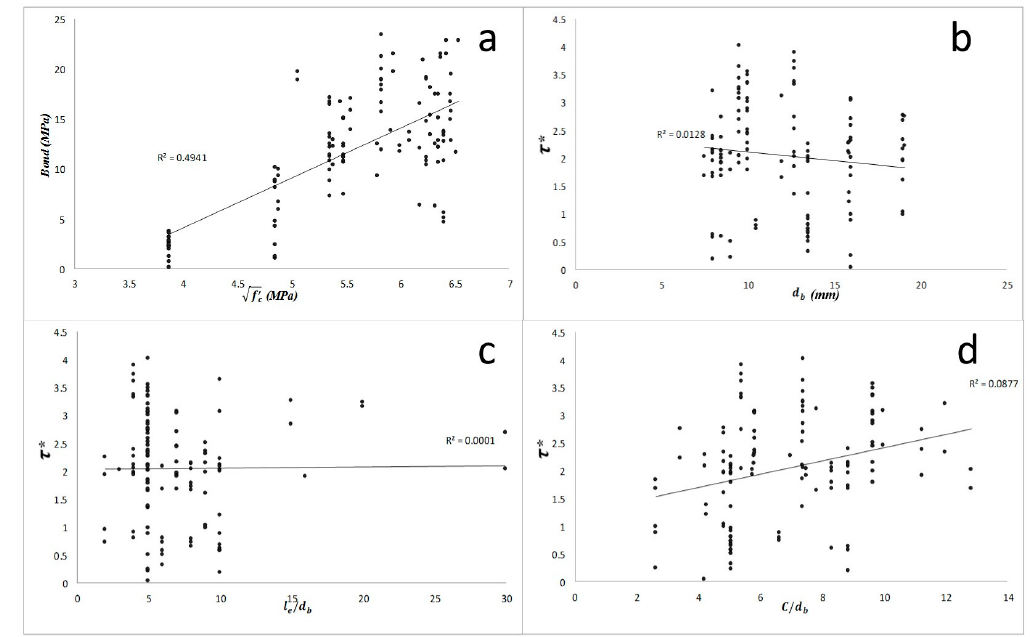
Figure 1. The effect of main factors on the bond strength of normal concrete (study groups 1 and 2): ( a ) square root of concrete compressive strength; ( b ) bar diameter; ( c ) embedment length to bar diameter ratio; ( d ) concrete cover to bar diameter ratio. τ ∗ is the normalized bond